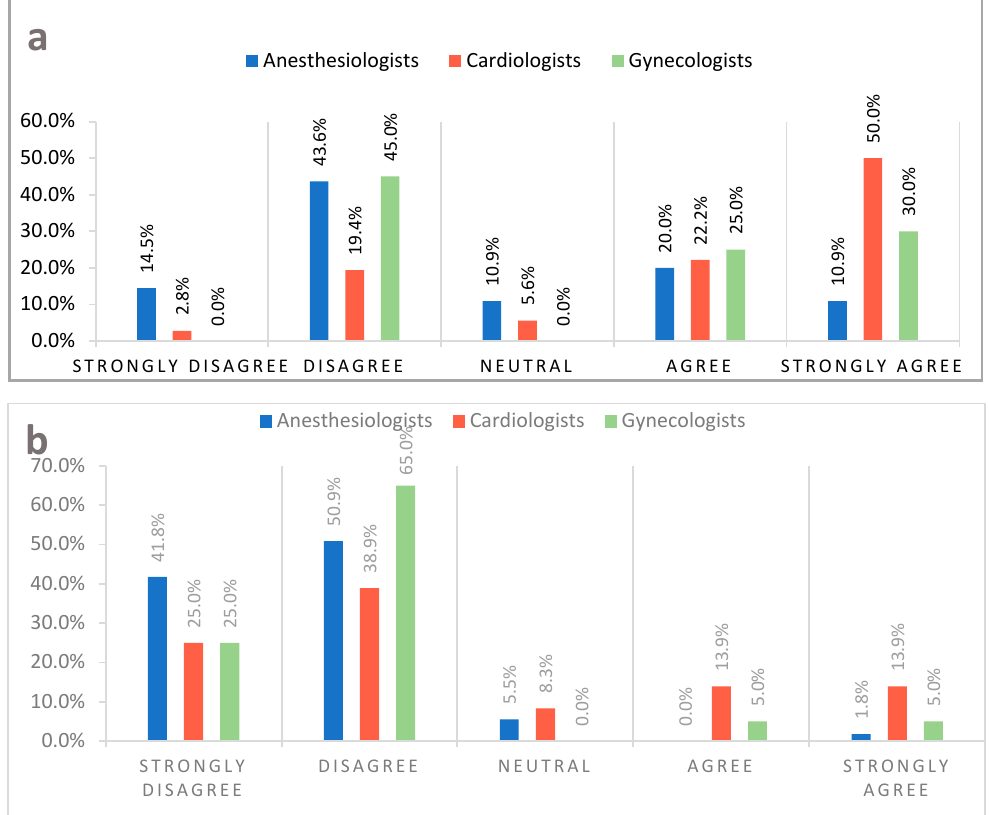
Figure 1. ( a ) Every woman with idiopathic pulmonary hypertension in reproductive age, regardless of the severity of the disease, should use an effective method of contraception. ( b ) Women with heart failure and a reduced ejection fraction, regardless of the puerperal clinical condition, should be discouraged from breastfeeding. Table 1. Inter-specialty response variability among surveyed physicians (A—anaesthesiologists, C—cardiologists, G—gynaecologists).